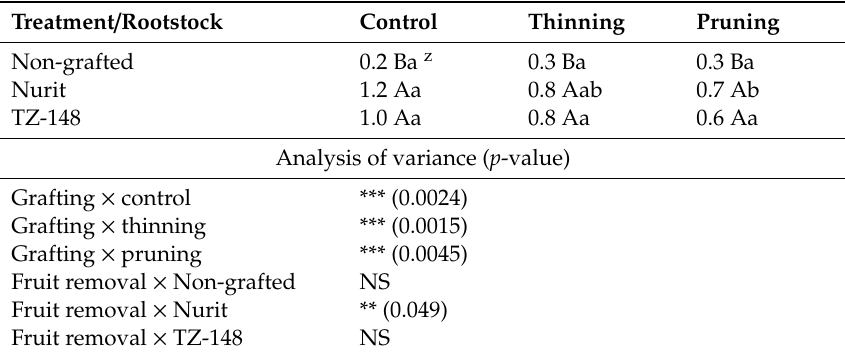
Table 1. E ff ects of rootstock, pruning and fruit-thinning on the number of marketable fruits / m 2 ( > 5 kg) at harvest (means of two-year